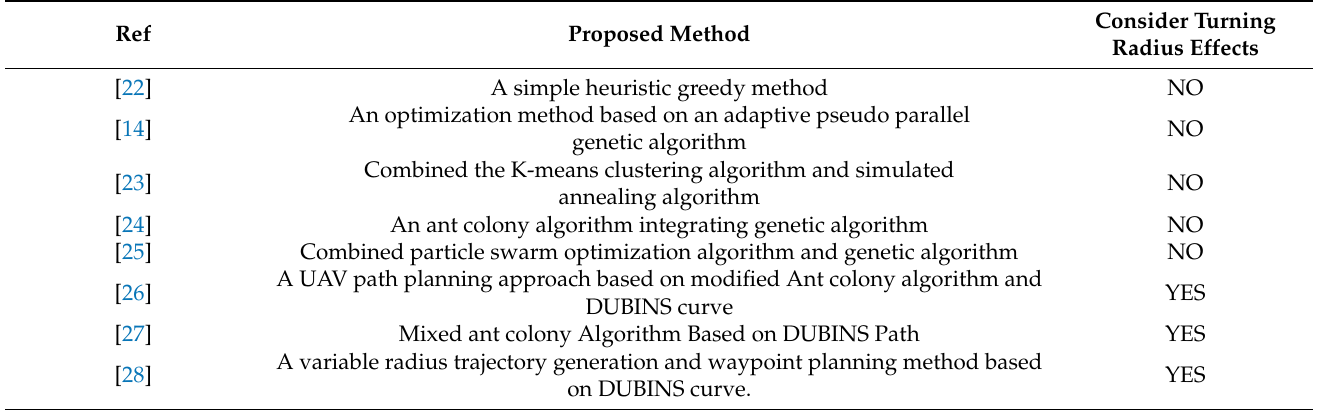
Table 1. Various route planning algorithms.